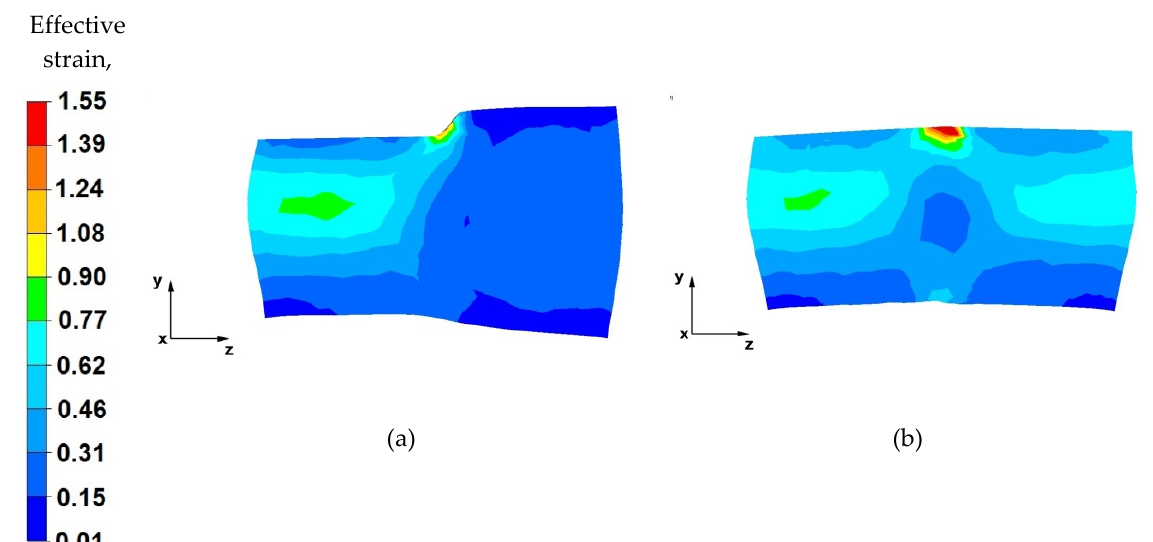
Figure 18. Distribution of the effective strain value on the longitudinal section of the AZ 91 forging, with 40% reduction in trapezoid and diamond anvils after slanting by 90°, ( a ) forged in the third pass, ( b ) forged in the fourth pass.